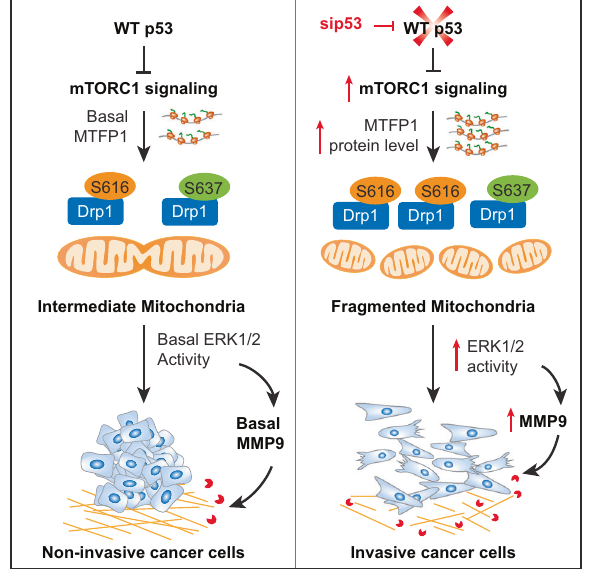
Fig. 7 Schematic model of how p53 modulates mitochondrial dynamics to constrain EMT, MMP9 expression, and invasive cell migration. WT p53 suppresses mTORC1-directed MTFP1 protein expression and the aberrant phosphorylation of Drp1 at the pro- fi ssion site S616, maintaining the predominantly intermediate state of mitochondria, and thereby constraining ERK1/2-mediated cell migration and invasion. Loss of WT p53 elevates mTORC1 activity, MTFP1 protein levels, and the phosphorylation of S616 on Drp1, shifting mitochondrial dynamics toward fi ssion to promote ERK1/2 activation and resulting in EMT-like changes in cell morphology, increased MMP9 expression, and cell